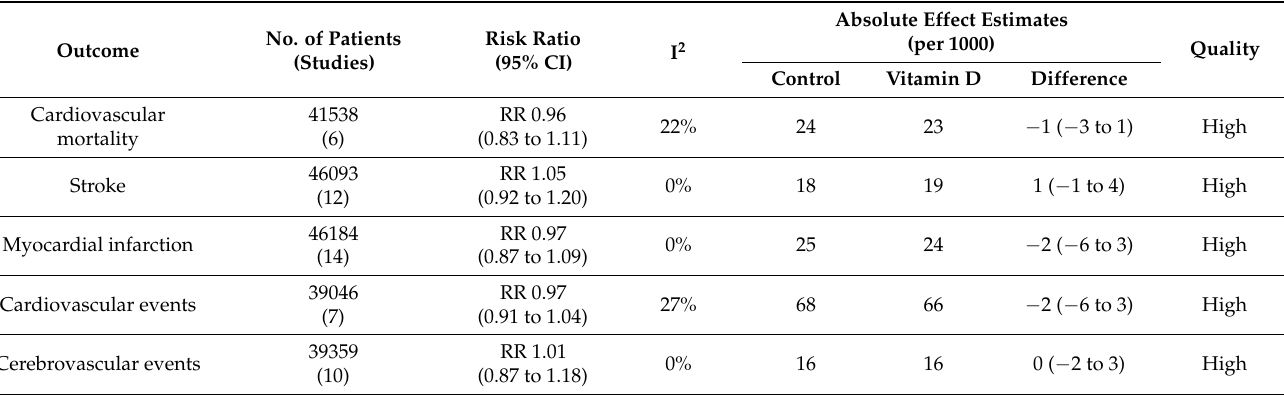
Table 2. Summary of Findings and Strength of Evidence in Studies Comparing Vitamin D vs. Control for CVD.